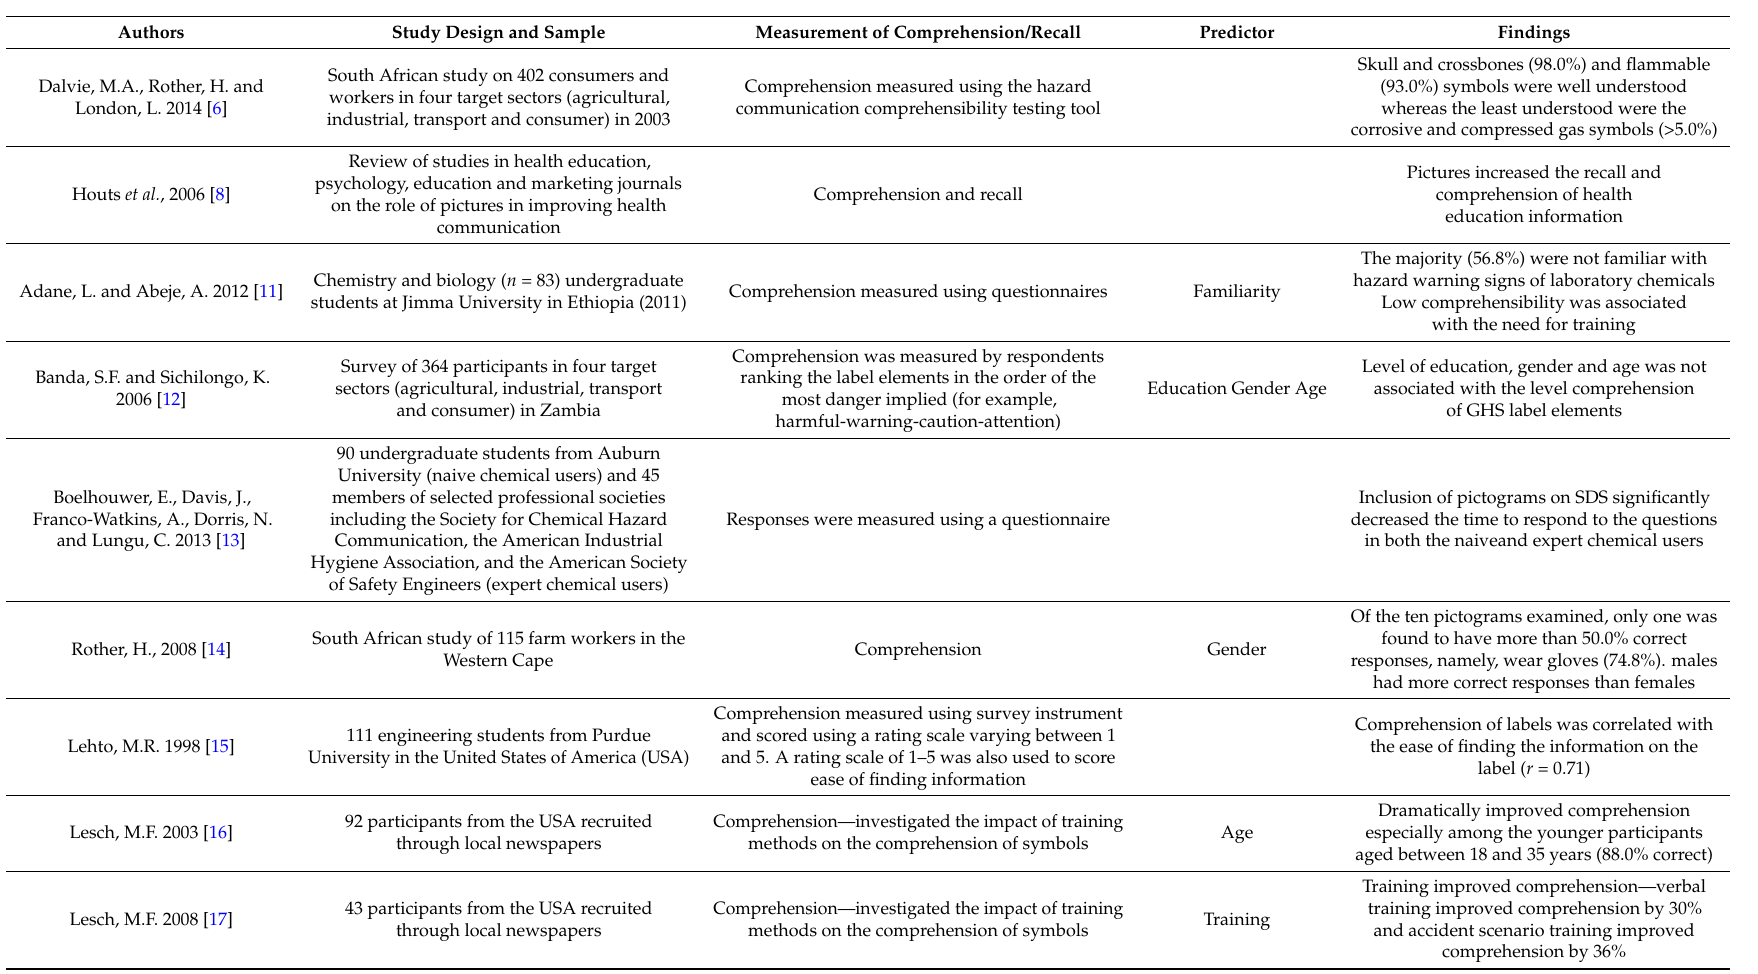
Table 1. Summary of studies investigating comprehension and/or recall of health and safety